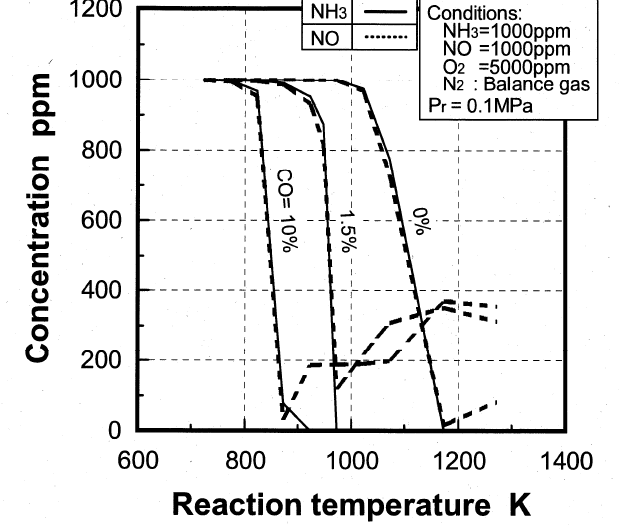
Figure 35. Effect of CO concentration on the temperature window as defined by